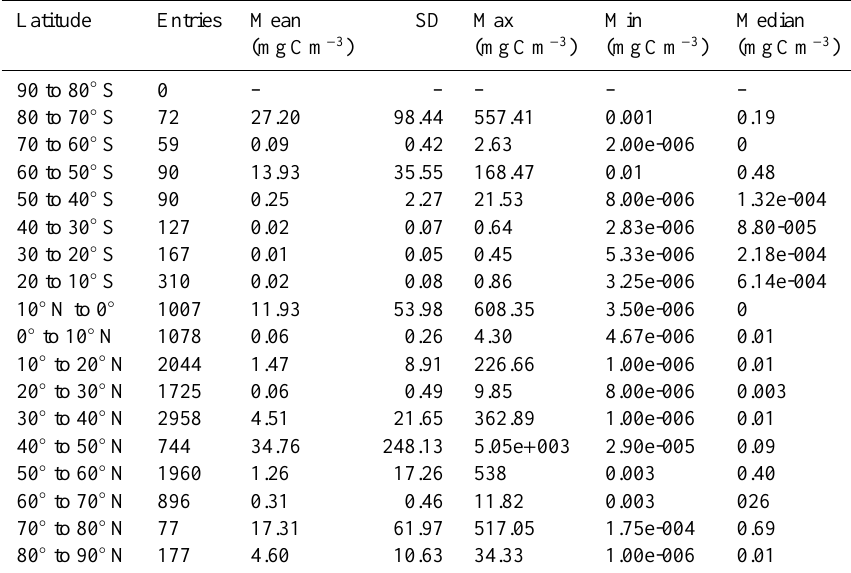
Table 4. Latitudinal distribution of abundance data in ten degree latitudinal bands (90 ◦ to 90 ◦ ). Mean, maximum (max), median and standard